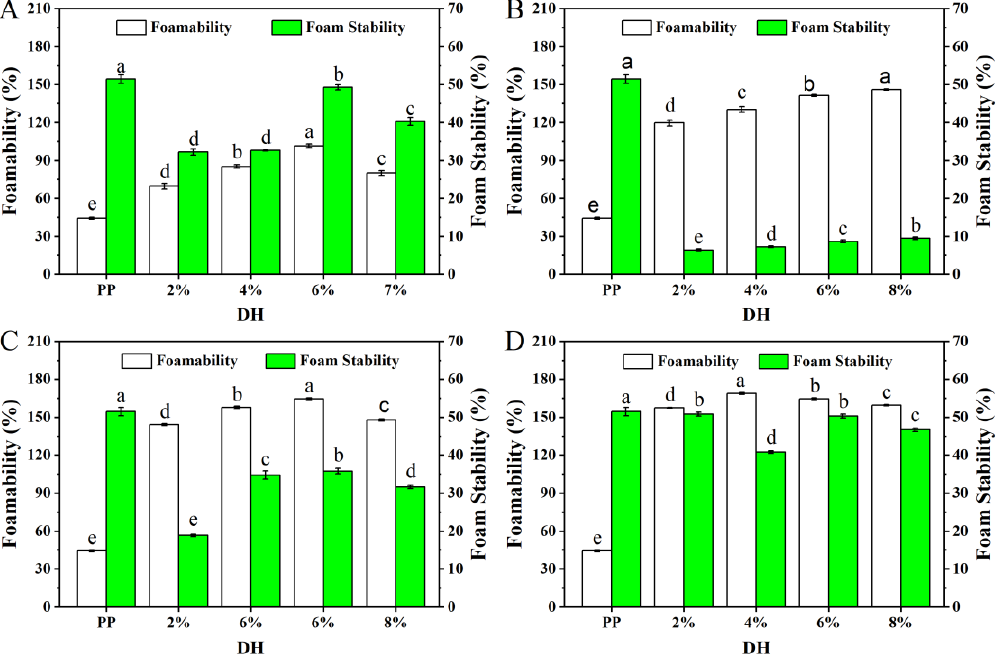
Figure 8. The foamability and foam stability of PP and PP with different DH samples (( A – D ) are flavourzyme, neutrase, alcalase, and trypsin treatment, respectively). The values reported represent means ( n = 3) ± SDs and different superscript letters indicate significant difference ( p < 0.05).